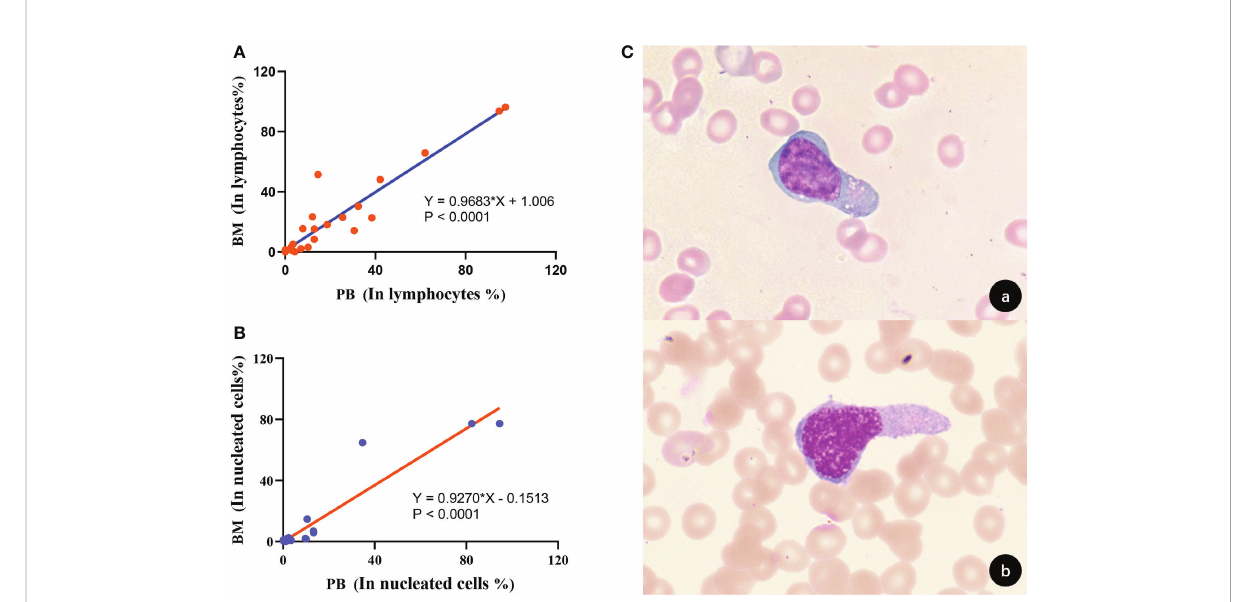
FIGURE 7 Correlation and homology of clonal T cell burden in BM and PB. (A) The proportion of clonal T cells to lymphocytes in BM and PB showed a positive correlation (p<0.0001). (B) The proportion of clonal T cells occupied nucleated cells in BM and PB showed a positive correlation (p<0.0001). (C) Morphological analysis con fi rmed that tumor T cells in BM and PB had consistent morphological features [ (A) , BM; (B) , PB;